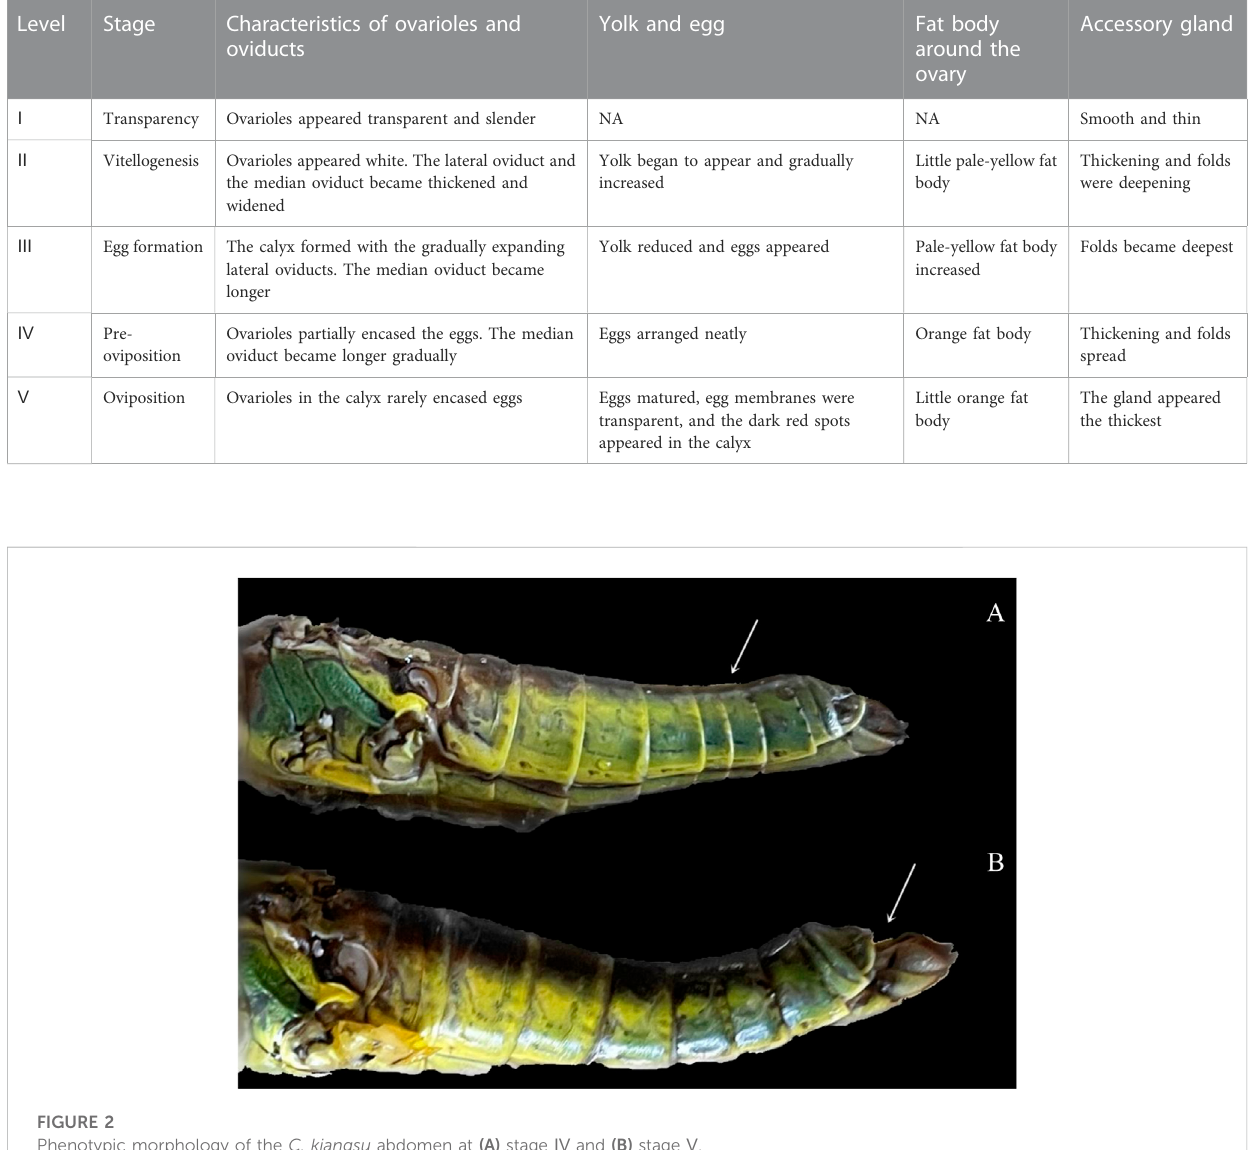
TABLE 1 Ovarian development characteristics of C. kiangsu at different stage standards.